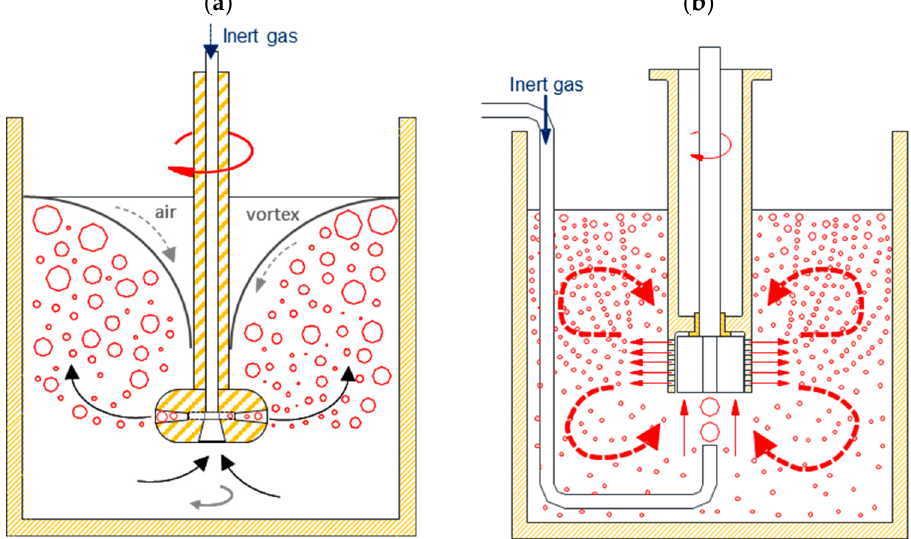
Figure 1. Schematic diagrams of ( a ) conventional rotary degassing and ( b ) HSMC degassing methods. The arrows indicate the flow pattern of the bubbles in the melt. Adapted from [24].